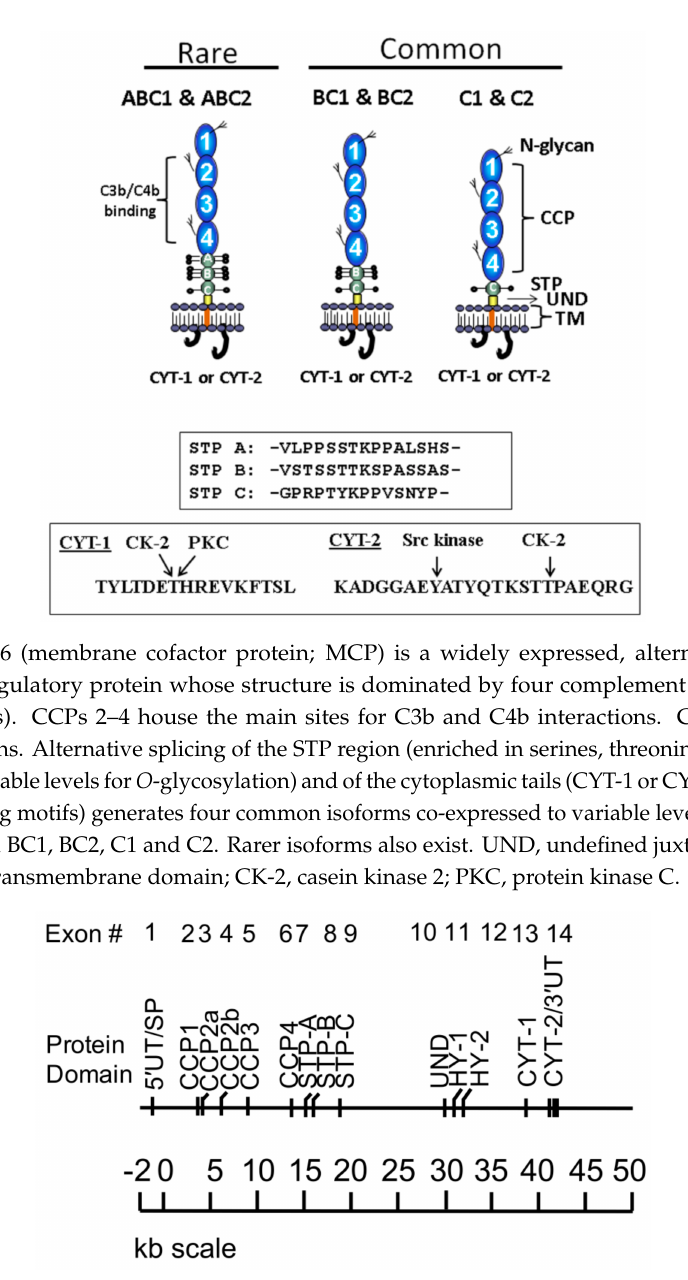
Figure 2. The gene for CD46. The alternatively spliced MCP gene lies at 1q3.2 and consists of 14 exons and13intronsforaminimumlengthof43Kb. Theexonnumberandcorrespondingdomainareindicated. Note that CCP2 and the hydrophobic domain (HY) are encoded by two exons. Abbreviations per Figure 1: 5 (cid:48) UT / SP (5 (cid:48) untranslated area and signal peptide); CYT-2 / 3 (cid:48) UT (cytoplasmic tail 2 and 3 (cid:48) untranslated